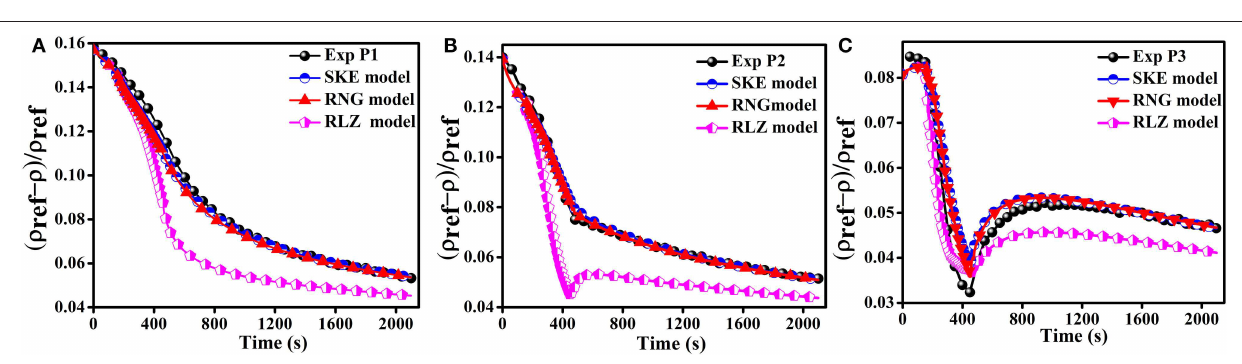
process was dominated by molecular diffusion when air-injection velocity was set to 0.411